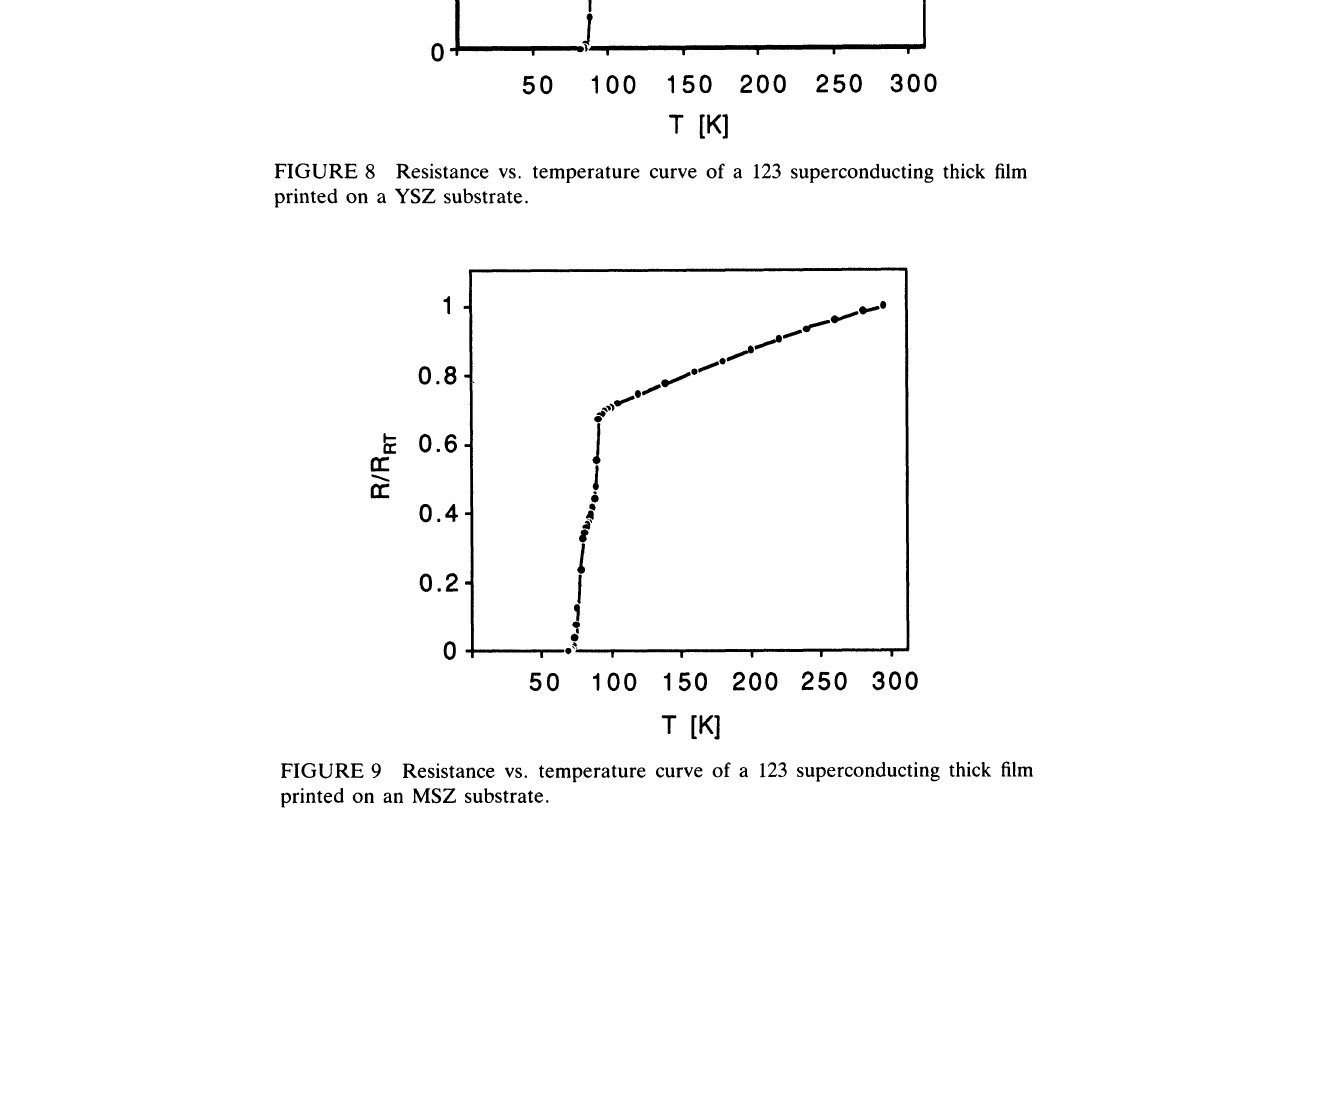
FIGURE 8 Resistance vs. temperature curve of a 123 superconducting thick film printed on a YSZ substrate.